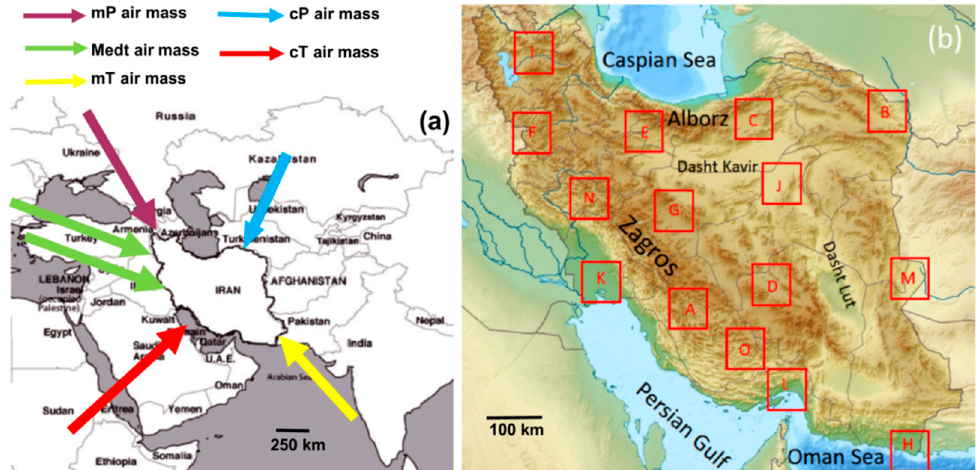
Figure 1. ( a ) Air masses influencing Iran and ( b ) spatial distribution of the 15 studied locations. (Shiraz (A), Mashhad (B), Shahrood (C), Rafsanjan (D), Hashtgerd (E), Marivan (F), Isfahan (G), Chabahar (H), Tabriz (I), Tabas (J), Ahvaz (K), Bandar Abbas (L), Zabol (M), Khoram Abad (N), and Darab (O)).